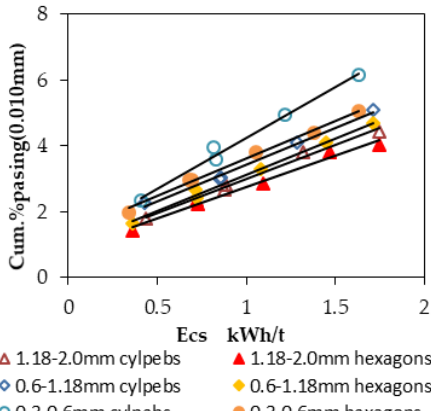
Figure 7. Relationship between the mass percentage of particles less than 0.01 mm and specific energy.